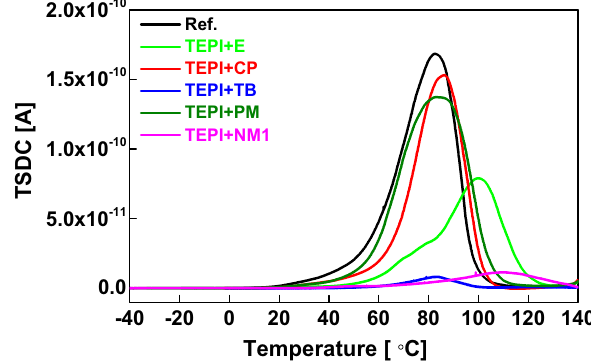
Figure 12: TSDC spectra of the nanocomposites fi lled with the reference silica and the modi fi ed silicas.